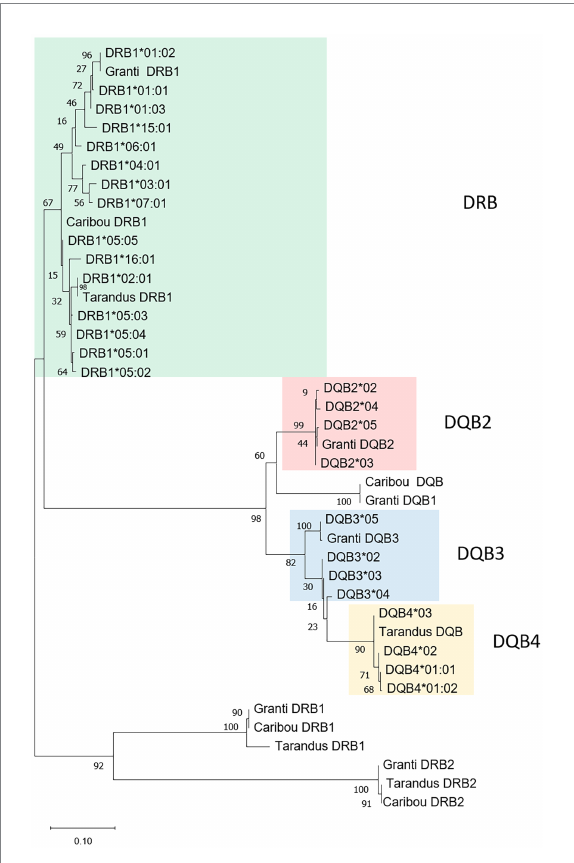
FIGURE 1 Phylogeny of deduced genomic MHCI amino acid sequences. Phylogenetic tree of deduced MHCI alpha1 through alpha3 domain sequences from the different reindeer genomes alongside selected MHCI sequences from cattle and humans. The tree with the highest log likelihood (−3,576,03) is shown. A discrete Gamma distribution was used to model evolutionary rate differences among sites [5 categories (+ G , parameter = 2,5,499)]. This analysis involved 23 amino acid sequences with 243 positions in the final dataset. See Supplementary data for sequences and sequence references.